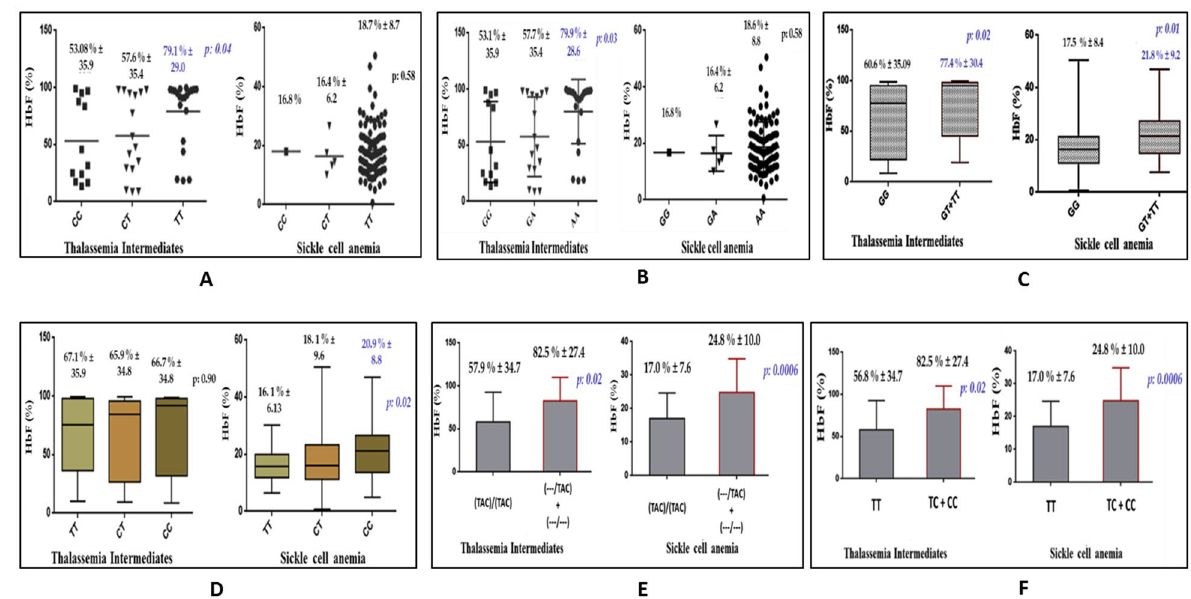
Figure 1. Association of the SNP genotypes with HbF levels in β-hemoglobinopathy patients. ( A ) XmnI polymorphism: − 158 (C → T), ( B ) + 25 (G → A) polymorphism, ( C ) rs1427407 (G → T) polymorphism, ( D ) rs11886868 (C → T), ( E ) rs66650371 (Intact TAC → 3 bp deletion) polymorphism, ( F ) rs9399137 (T → C)